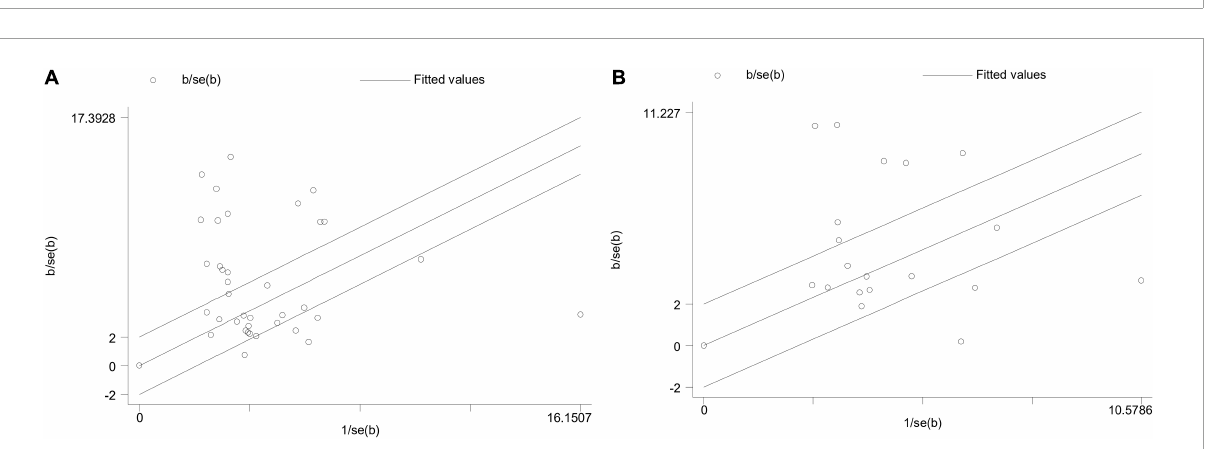
FIGURE7 Forest plot of teaching satisfaction for BOPPPS compared with LBL.